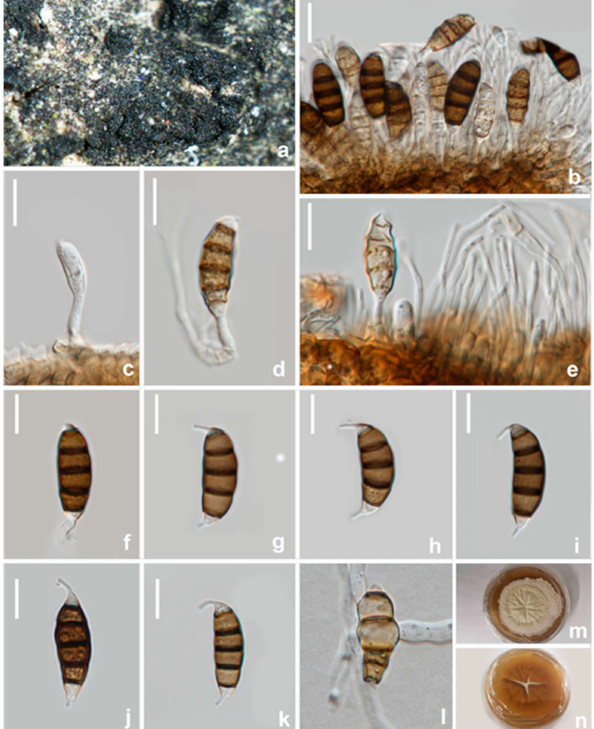
Figure 14. Seiridium oleae (HKAS 123220, holotype). ( a ) Appearance of conidiomata on host substrate. ( b – f ) Conidiogenous cells and conidia. ( g – k ) Conidia. ( l ) Germinating conidium. ( m , n ) Upper and reverse view of the colony on PDA. Scale bars: ( b – l ) = 10 µ